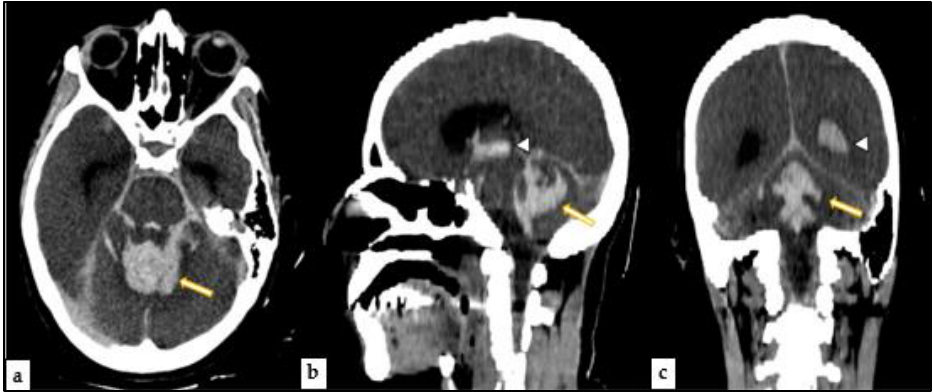
Figure 1. PMCT — ( a ) Axial image revealed signs of intracerebral hemorrhage of the cerebellum (yellow arrow). ( b ) Sagittal view showed another hemorrhage site, the basal ganglia (white and yellow arrows). ( c ) Coronal view of the brain offered another type of hemorrhage view (white and yellow arrows).